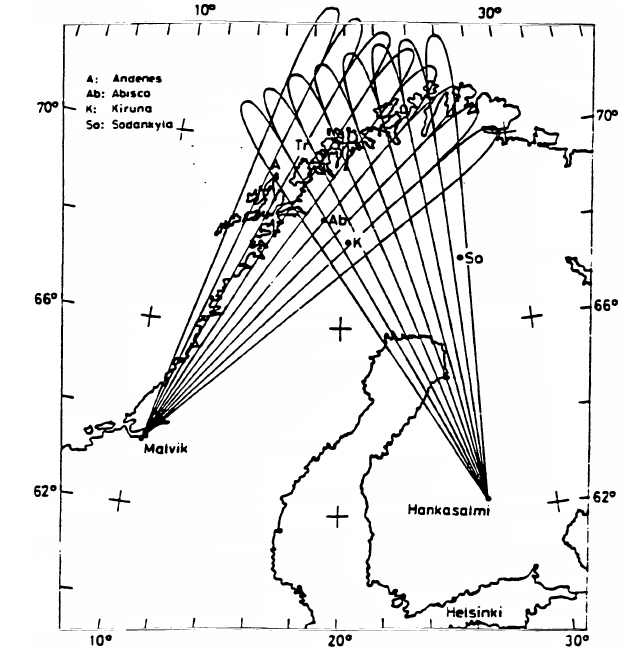
Figure 1. The STARE radar stations in Norway and Finland, with eight narrow antenna lobes from the two stations. The STARE field of view covers a geomagnetic latitude range from 65 to 70 ◦ .